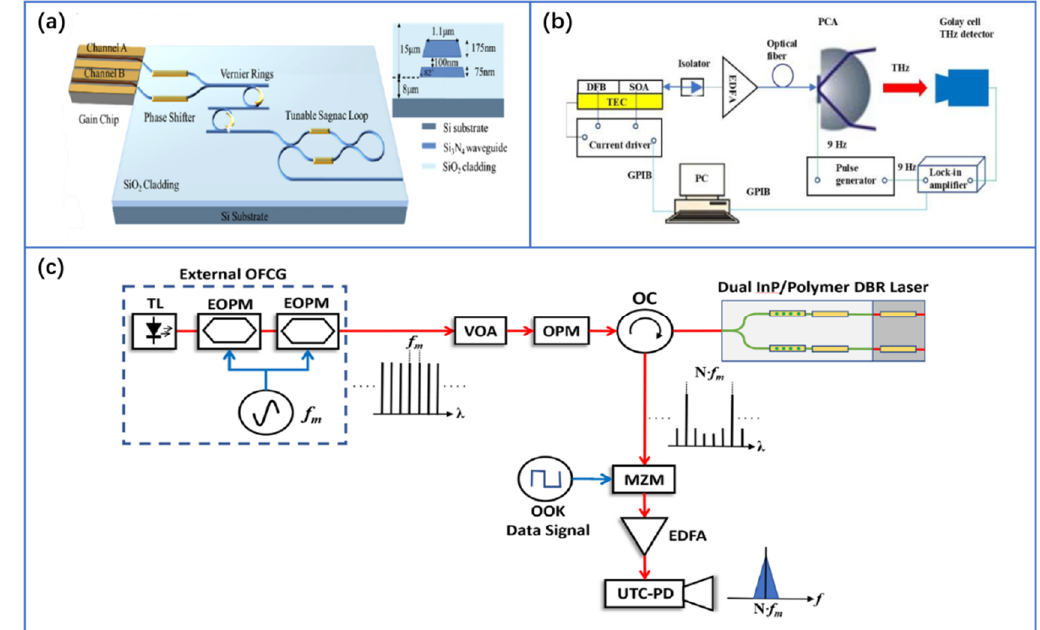
Figure 5. ( a ) Schematic view of a tunable InP-Si 3 N 4 hybrid ECL with dual-parallel gain. Reprinted with permission from [76] © The Optical Society, 2021. ( b ) Setup for the THz generation and detection system based on the dual-mode DFB semiconductor laser. Reproduced with permission from J. H. Marsh, 2018. ( c ) Schematic of the experimental setup for optical injection locking of the hybrid dual InP/Polymer DBR photonic integrated circuit for THz carrier wave generation. Reproduced with permission from [87], Copyright, Springer Nature, 2018.